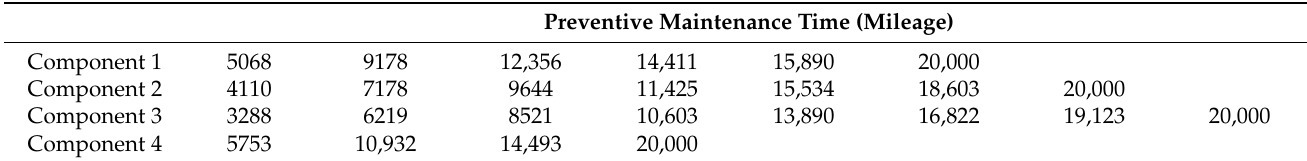
Table 7. Preventive maintenance time of each component